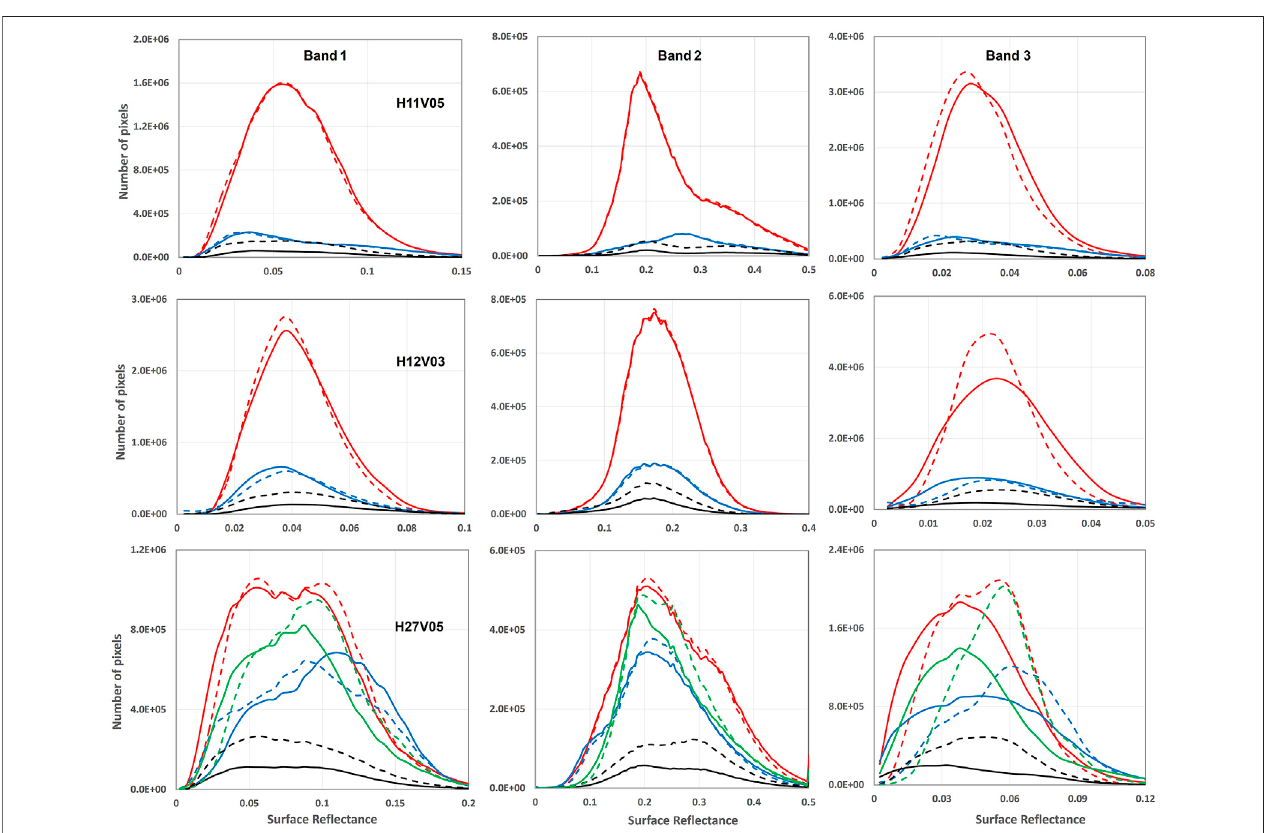
FIGURE 6 | Annual histograms of MCD19A1 and MOD09 surface re fl ectance in bands 1 – 3 (columns) from high quality pixels over tiles H11V05, H12V03 and H27V05 (rows) for 2018. The red, blue and black lines represent cases (A) , (B) and (C) as in Figure 5 . The added histograms for H27V05 (green lines, magni fi ed by a factor of 2.5) show the SR distributions at high AOD. The solid and dashed lines stand for the MCD19A1 and MOD09 SR, respectively.